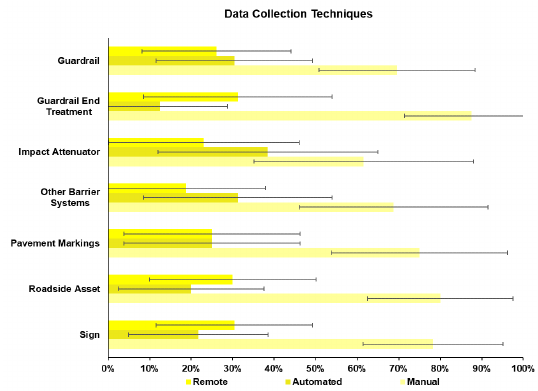
Figure 8 . Breakdown of state DOTs Data